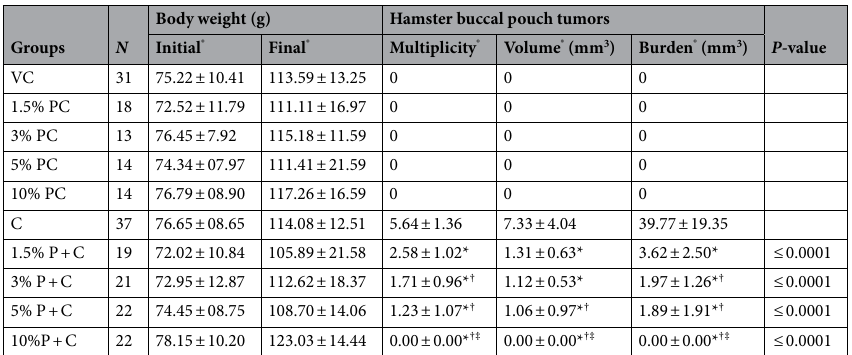
Table 1. Effect of pre and concurrent treatment of PBPs on DMBA induced hamster buccal pouch carcinogenesis. *Significantly different from Carcinogen P ≤ 0.0001, † Significantly different from 1.5% PBPs + Carcinogen P ≤ 0.0001, ‡ Significantly different from 5% PBPs + Carcinogen P ≤ 0.0001, ® Represented as Mean ± standard deviation. 6–8 weeks old hamsters were randomised into ten groups as follows: Vehicle control (VC) 1.5% PBPs control (1.5% PC) 3% PBPs control (3% PC) 5% PBPs control (5% PC) 10% PBPs control (10% PC) Carcinogen (C) 1.5% PBPs + Carcinogen (1.5% P + C) 3% PBPs + Carcinogen (3% P + C) 5% PBPs + Carcinogen (5% P + C) 10% PBPs + Carcinogen (10% P + C). PC (1.5%, 3%, 5% and 10%) and P + C (1.5%, 3%, 5% and 10%) were primed with 1.5%, 3%, 5% and 10% PBPs respectively for two weeks as a